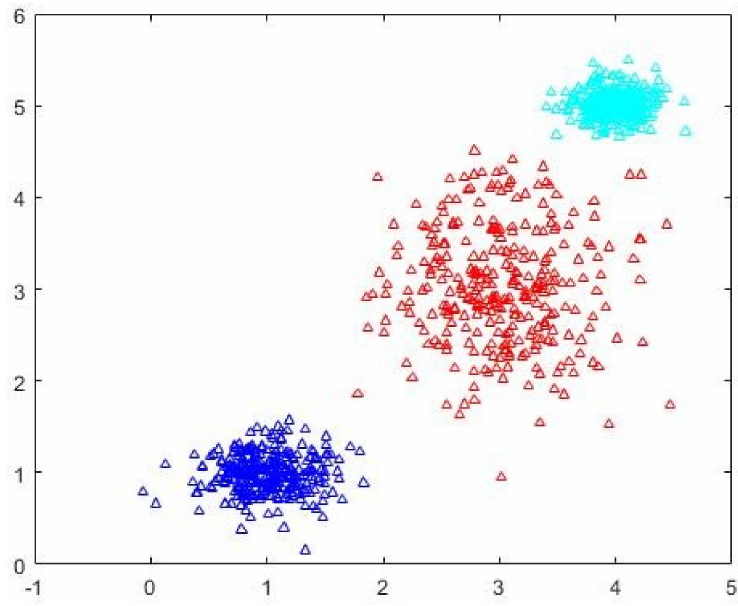
Figure 4. CDE-FCM with evolved initial cluster prototypes for c = 3. FCM-AO, PSO-V, GAKFCM, and EwFCM are run for c = 2 to c = 30. For ADEFC and CDE-FCM the vector representation is of length 60 with d = 2 and c max = 30. The run-time parameters are chosen such as the convergence criteria for all algorithms are roughly the same. For comparison, the run-time of the different algorithms is presented in Table 3. As can be seen, there is not much to be gained by using sophisticated schemes to address the problems of prototype initialization and unknown number of clusters for a small well- separated dataset as Data1. The naïve version of FCM-AO with random initializations works as well as any other scheme and in a fraction of the